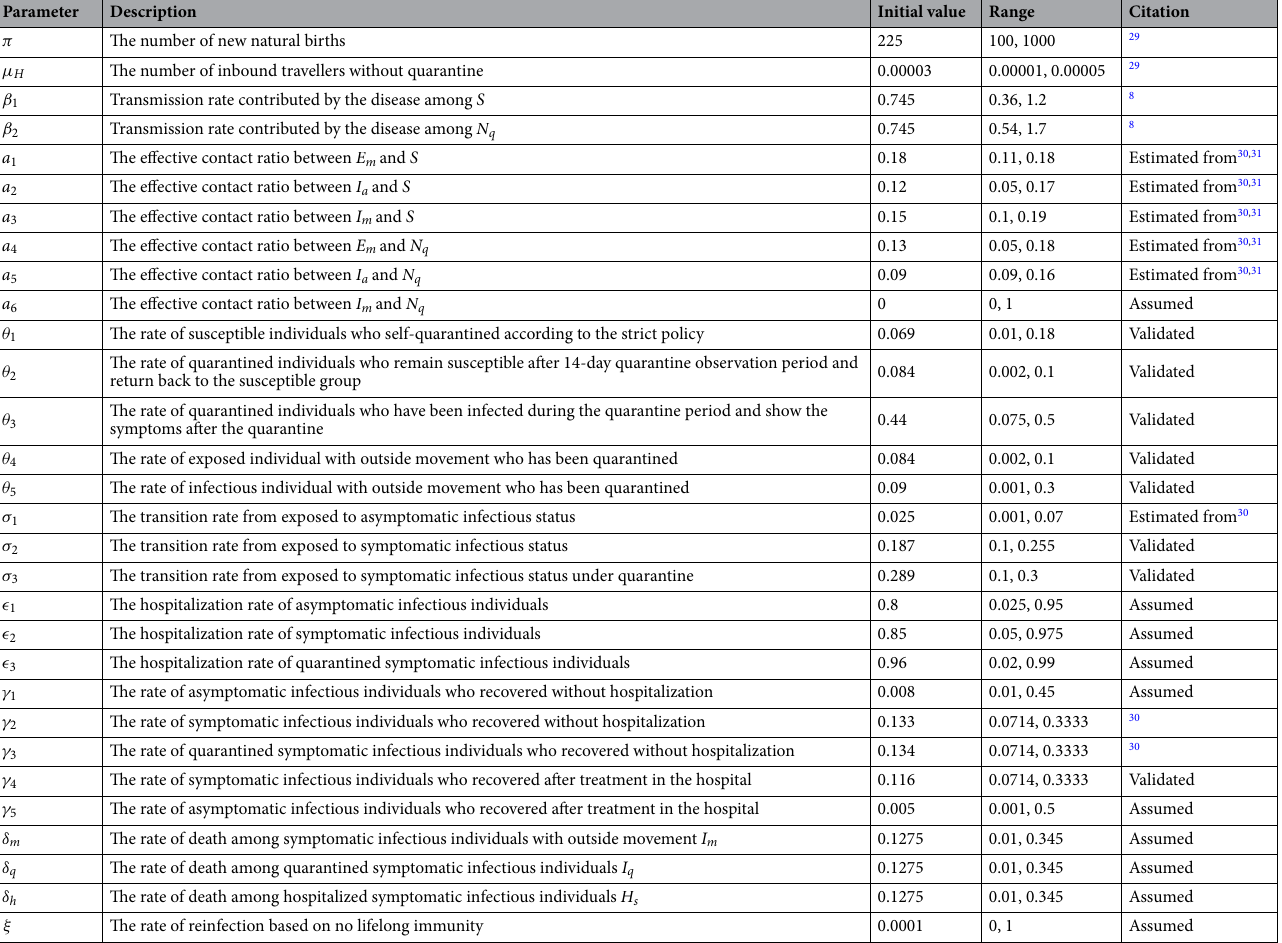
Table 2. Parameter descriptions and values.